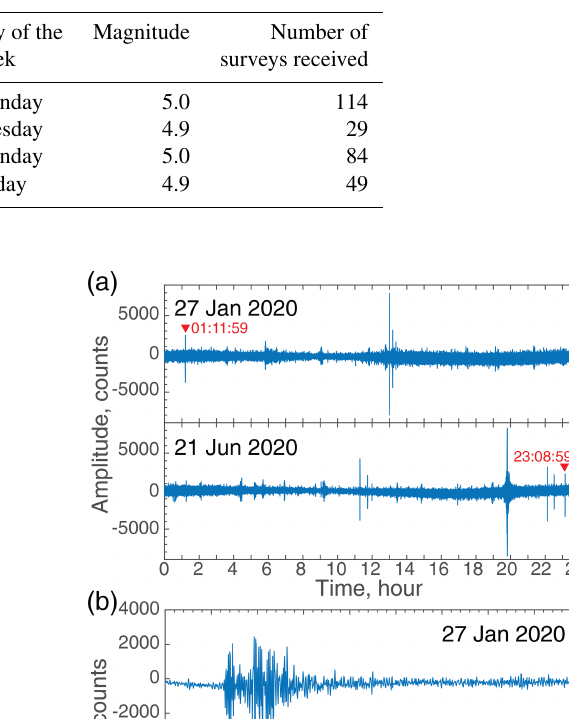
Table 1. Earthquakes at the Guerrero coast from 2016–2020 at similar distances from Mexico City and similar magnitudes.